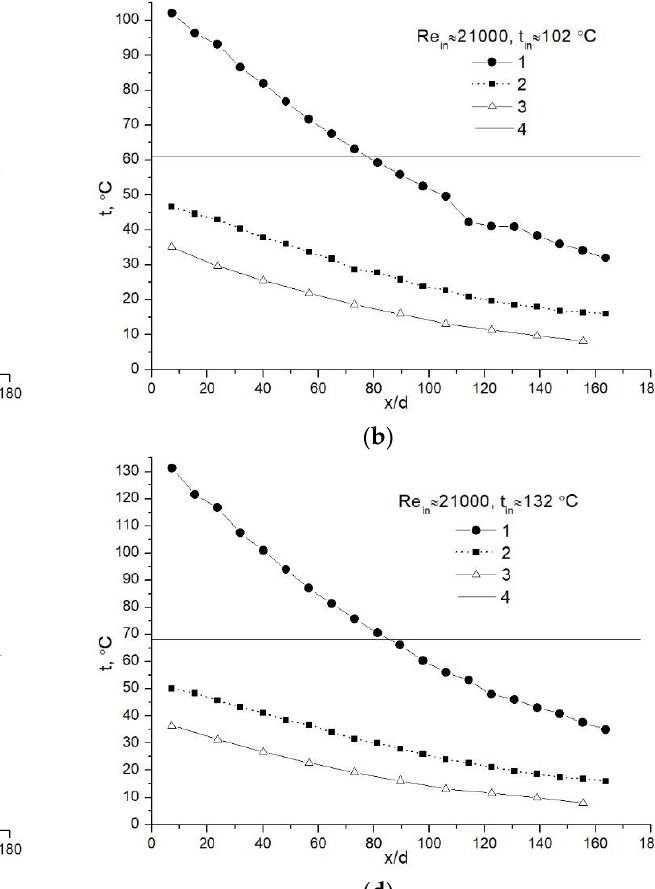
Appl. Sci. 2022 , 12 , 12650 10 of 18 Figure 5. Temperature distribution in the heat exchanger at Re in ≈ 21,000, different flue gas inlet temperatures and the cooling water flow rates of 60 kg/h ( a , c ) and 120 kg/h ( b , d ): (1) centre of the tube, (2) the inner wall of the tube, (3) cooling water, (4) the dew point temperature.